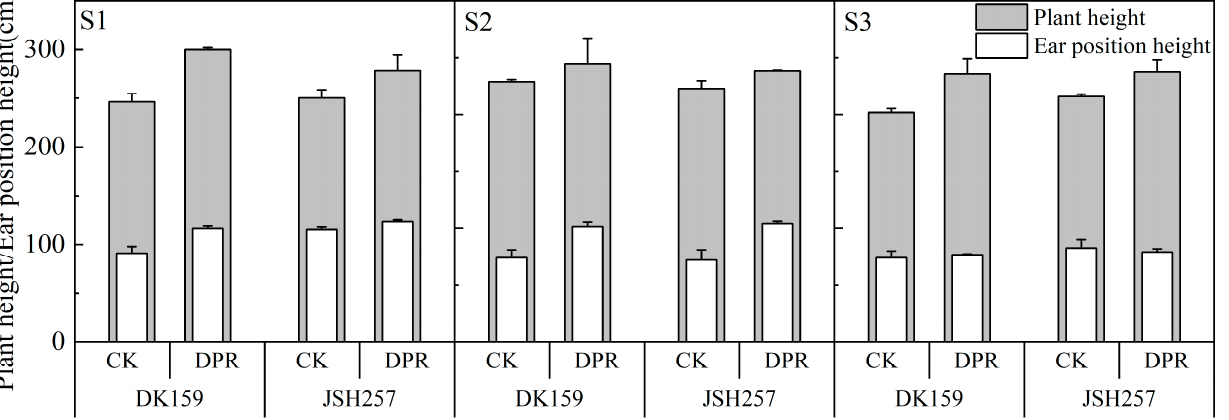
Figure 1. Effects of deep straw return to field on plant height and ear height of maize in saline land.